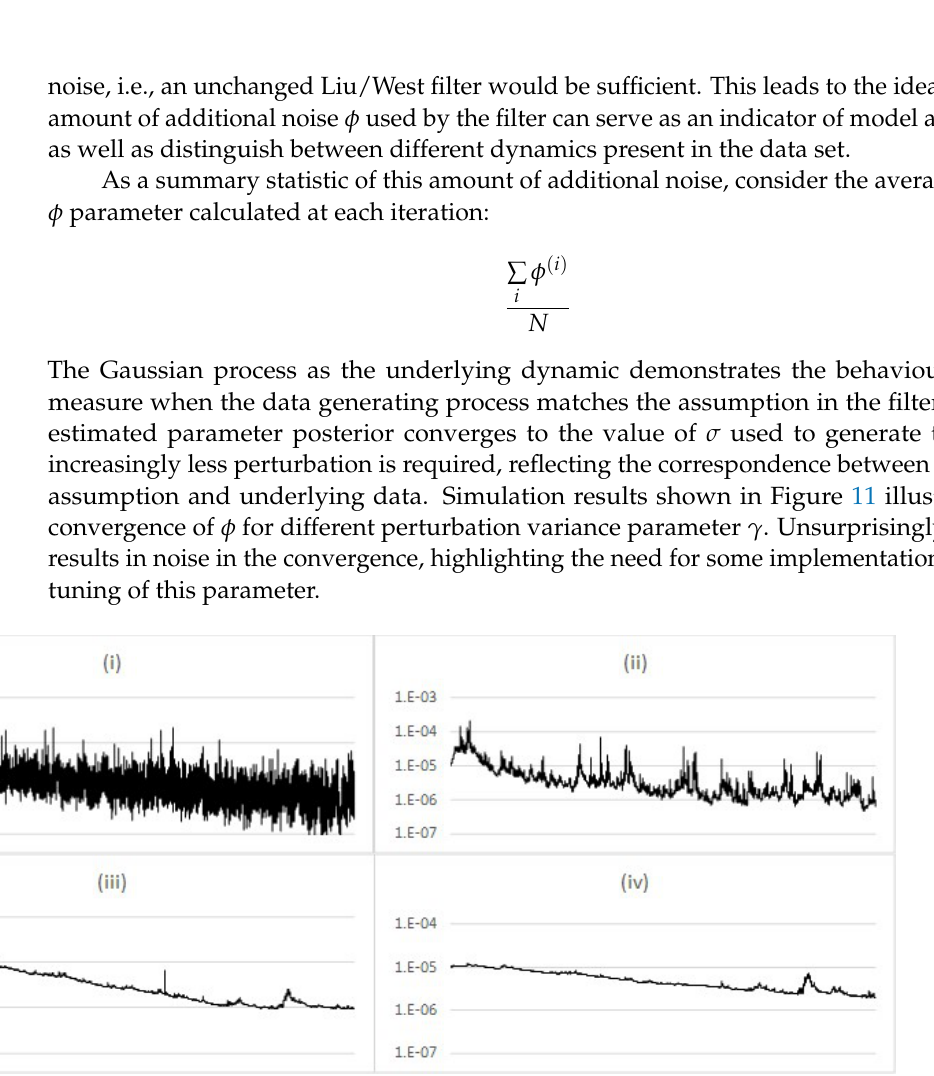
Figure 11. Comparison of average φ (log-scale) for the Gaussian model with different values of filter perturbation variance γ ( i ) 1.0; ( ii ) 0.01; ( iii ) 0.001; ( iv )